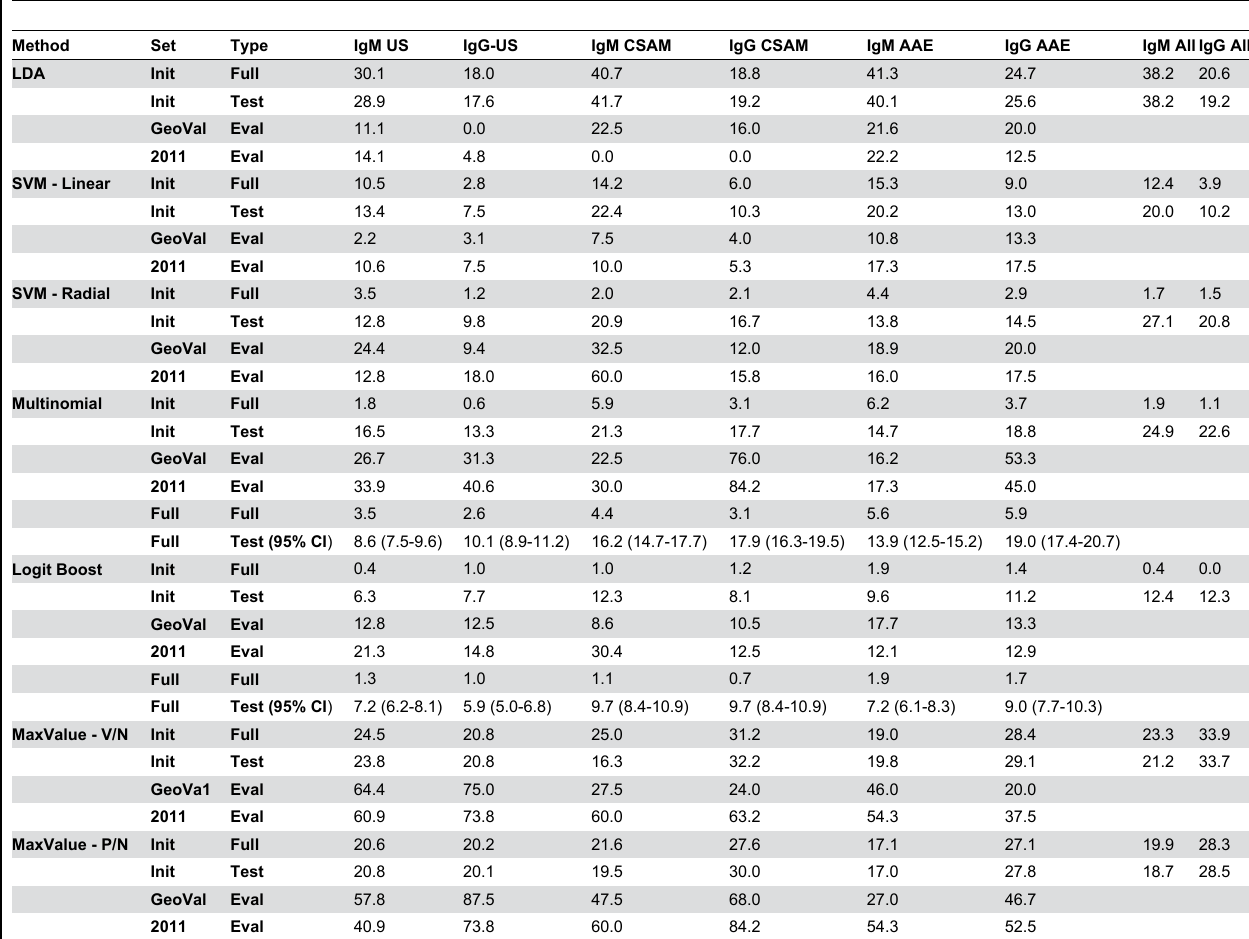
Table 7. Error rates (%) for all classification methods and geographic testing batteries.